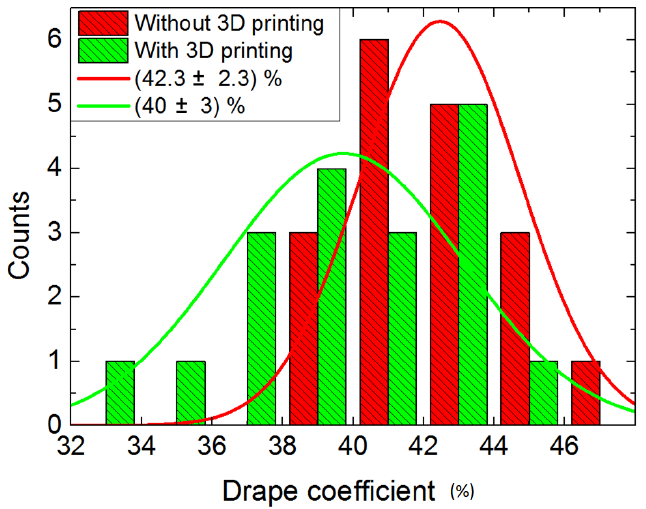
Figure 9. Drape coefficients without and with 3D printed geometries. The values are significantly different at p <